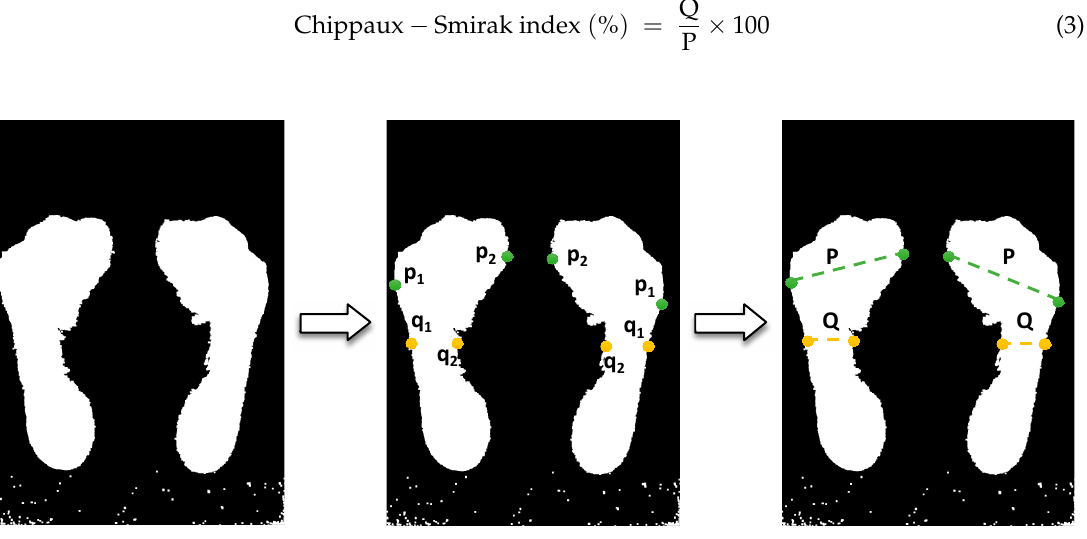
Figure 8. Process of the Chippaux-Smirak index calculation.